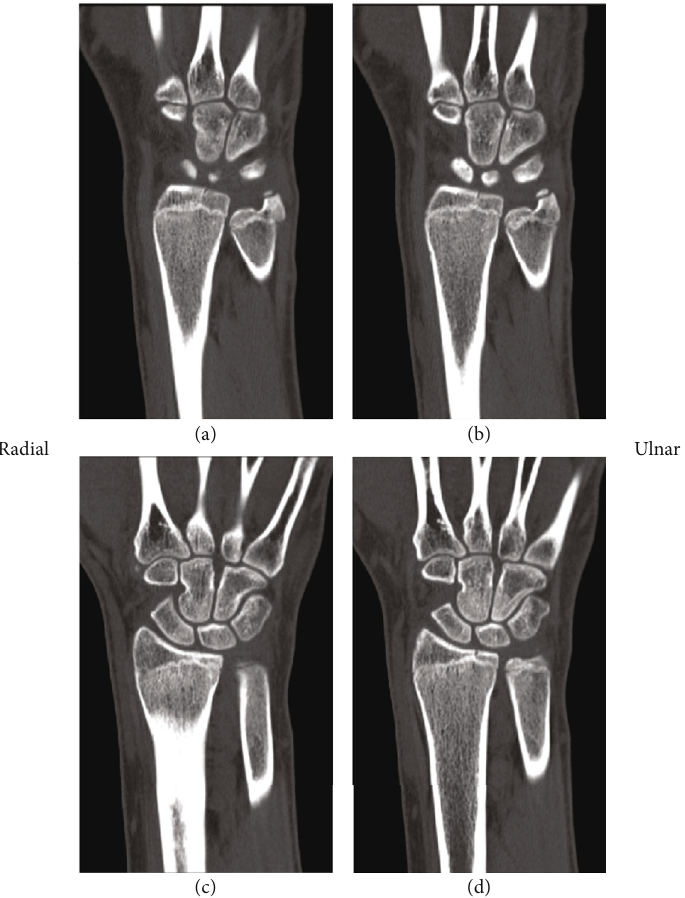
Figure 4: Coronal CT view showing location of fracture at dorsal rim with interval healing and narrowed and fusing radial